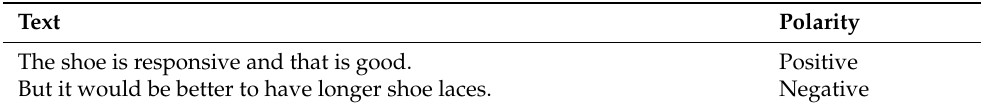
Table 4. Possible punctuation placement to produce more sentiment information. Text